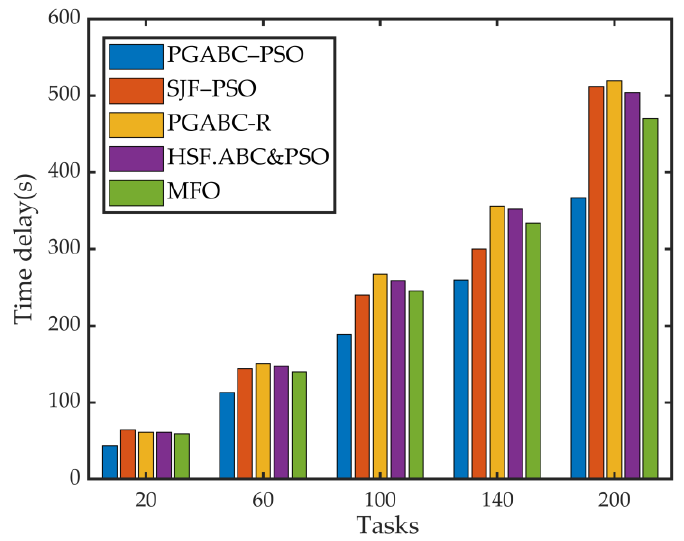
Figure 9. Total system delay for the five schemes varying with task number.